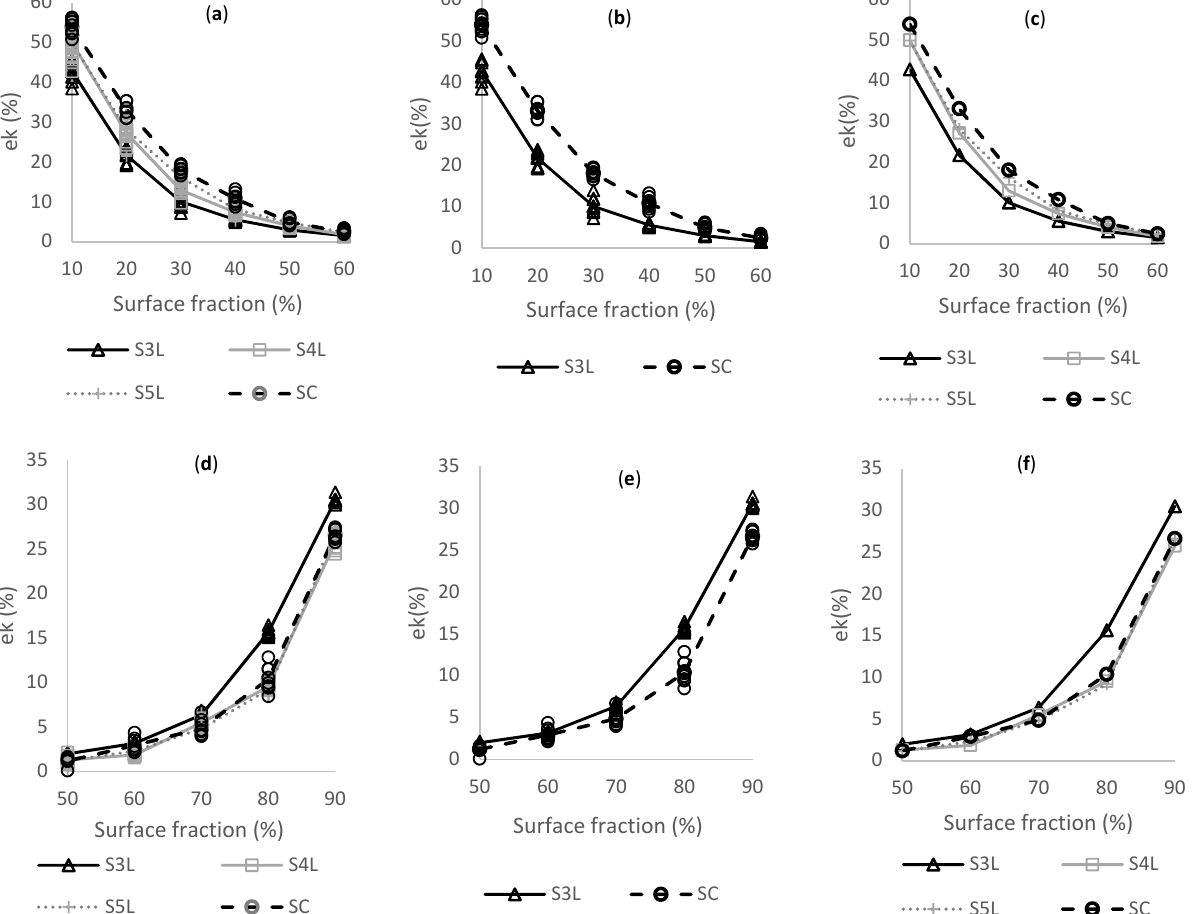
Figure 13. Conduction efficiency ( ε k ) as a function of φ for ω . ( a – c ) show conduction efficiency for the matrix phase in a range of 10% to 60% and ( d – f ) is for an agglomerate phase in a range of 50% to 90%.